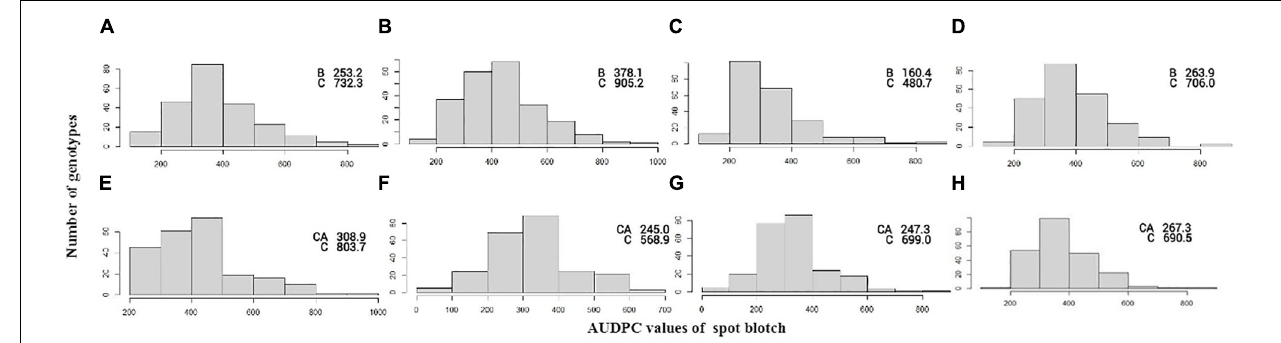
FIGURE 1 | Frequency distribution of AUDPC scores in the BC population in the year 2013 (A) , 2014 (B) , 2015 (C) , and mean (D) and CC population in the year 2014 (E) , 2015 (F) , 2016 (G) , and mean (H) . AUDPC score of parents BARTAI, CASCABEL, and CIANO T79 is denoted as B, CA, and C.